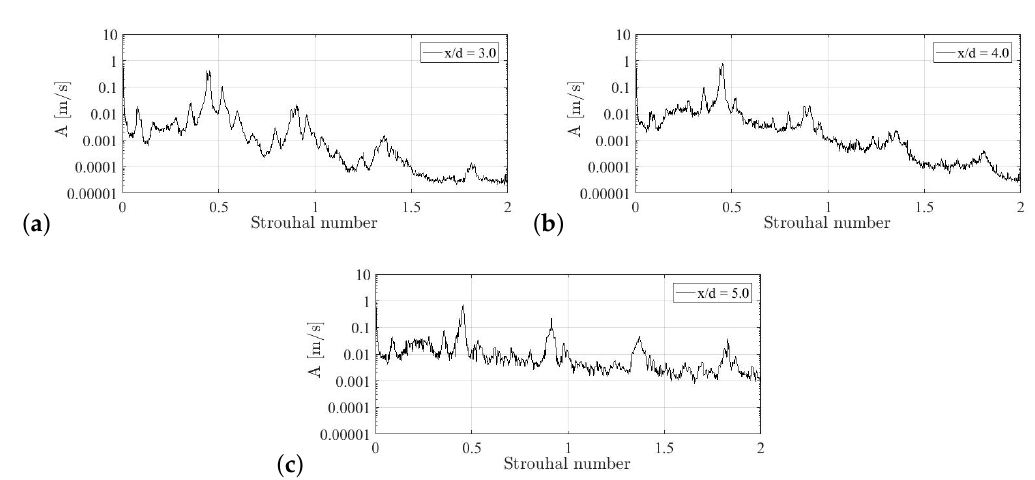
Figure 9. Evolution of spectra of axial velocity fluctuations, S = 0.5, L / D = 15, Re = 5000: ( a ) x / D = 4, ( b ) x / D = 6, ( c ) x / D = 8 .